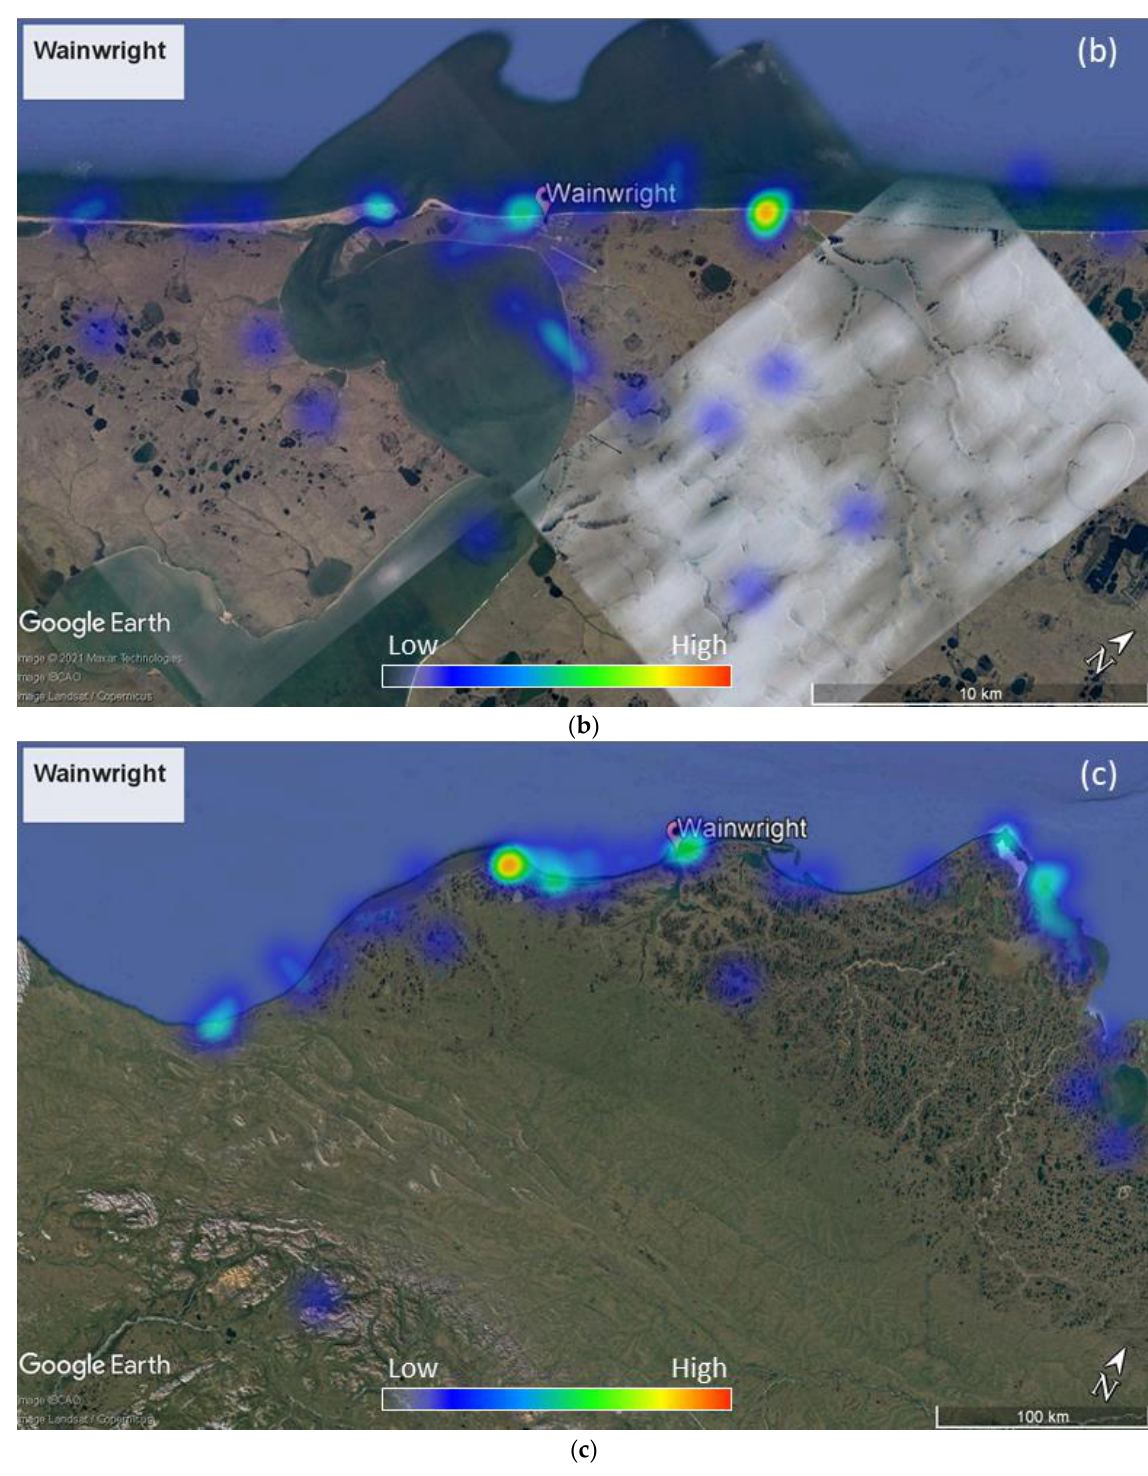
Figure 13. Heatmaps of permafrost degradation and coastal erosion in Wainwright: ( a ) 800 m, ( b ) 10 km, and ( c ) 100 km.